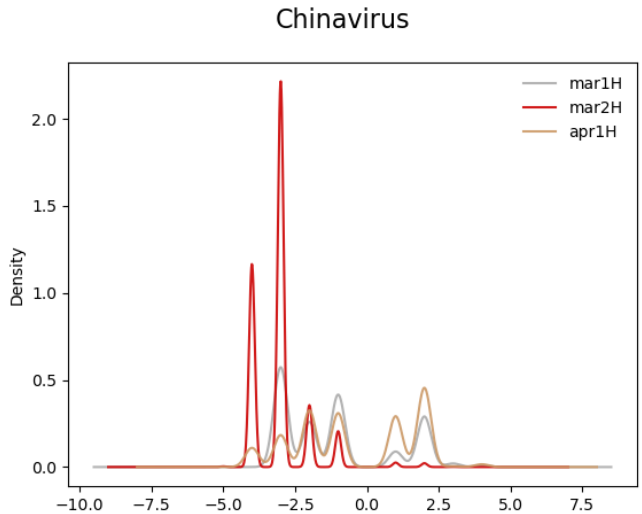
Figure 2. Sentiment score distribution of contextual words of